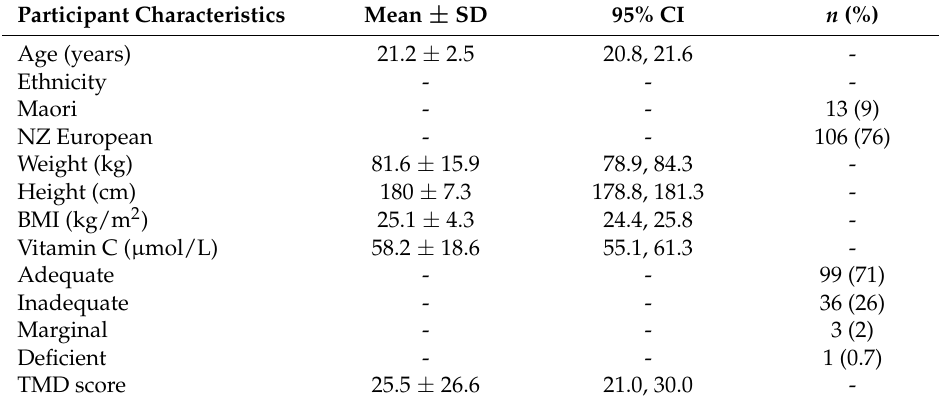
Table 1. Characteristics of individuals who completed the